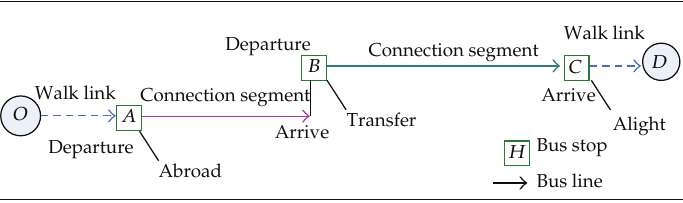
Figure 2: Structure of